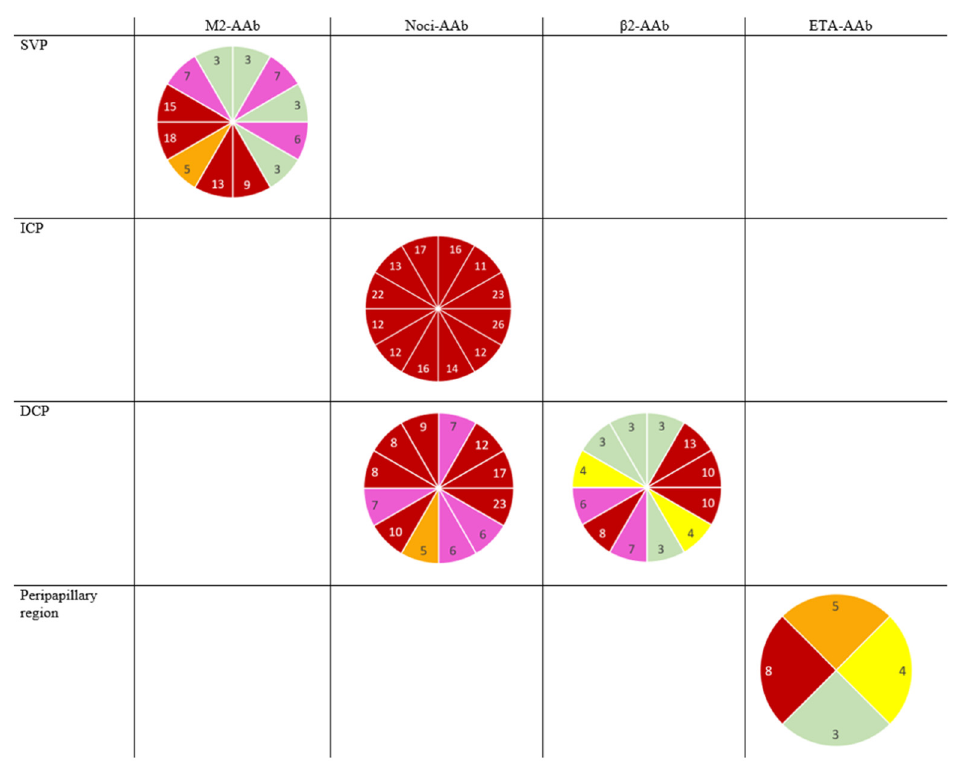
Figure 4. Schematic color-coded sketch of the number of significant interactions: sectorial vessel density of SVP, ICP, DCP ( n = 12), and peripapillary region ( n = 4) is presented considering the effect of the M2-AAb, Noci-AAb, β 2-AAb, and ETA-AAb; red, n ≥ 8; pink, n = 6–7; orange, n = 5; yellow, n = 4; green, n = 2–3; gray, n = 0–1; SVP—superficial vascular plexus of the macula; ICP—intermediate capillary plexus of the macula; DCP—deep capillary plexus of the macula.